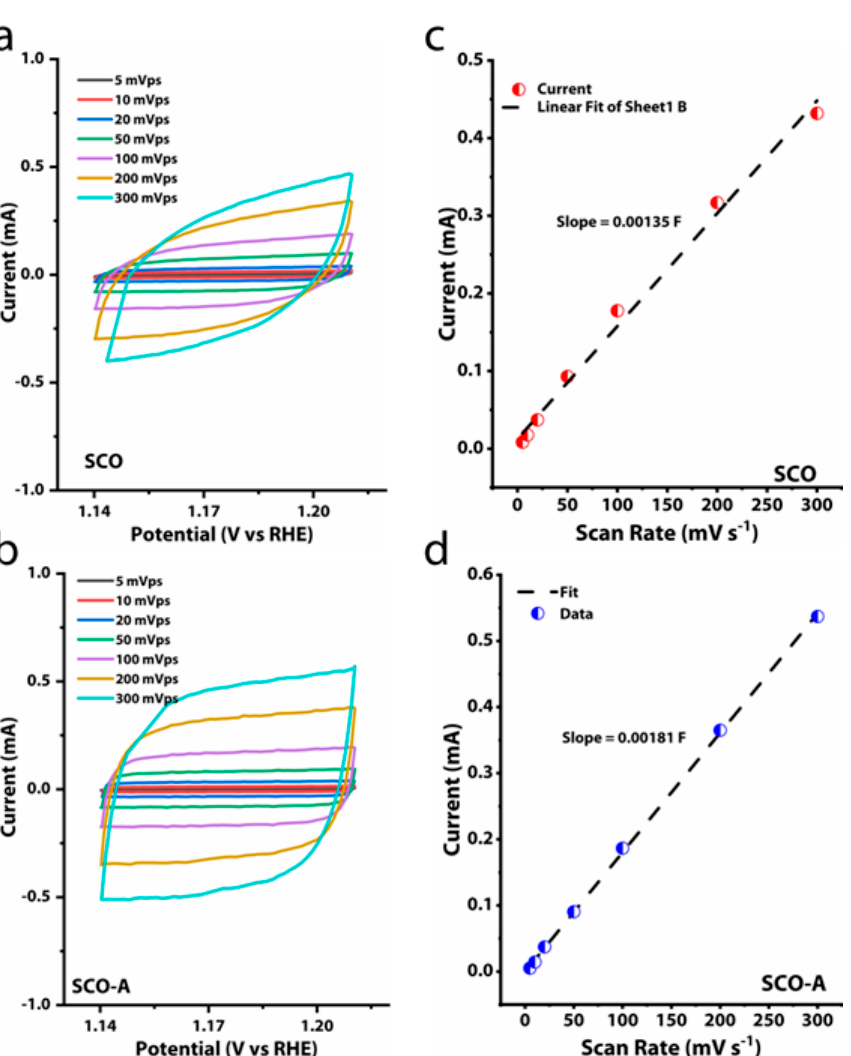
Figure 4 . CV curves and the Tafel Slope. CV curves at different scan rates for ( a ) SCO; ( b ) SCO-A. Tafel plots for ( c ) SCO. ( d ) SCO-A.